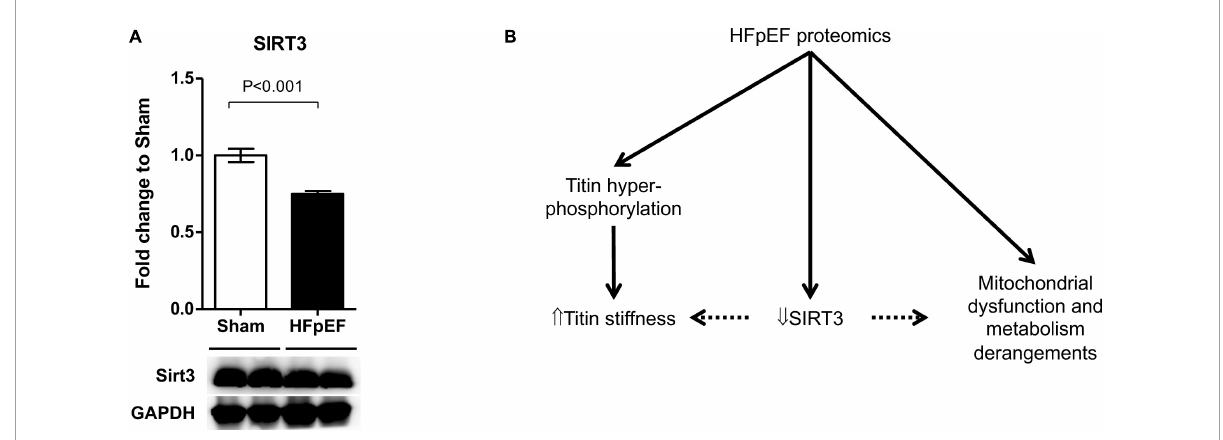
FIGURE6 SIRT3 regulation in HFpEF. (A) SIRT3 protein expression in the left ventricles from HFpEF mice ( N = 11) and Sham ( N = 7). Data are presented as mean ± SEM. Statistical analysis by two-tailed Student’s t -test. (B) Overview of proposed SIRT3 regulatory system in